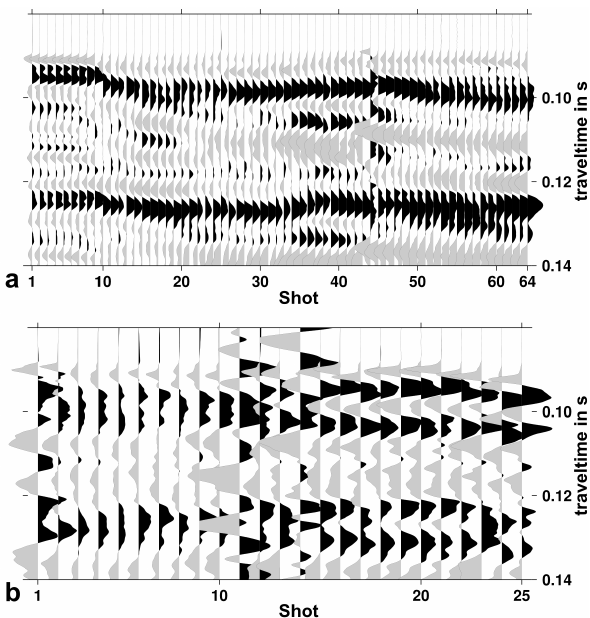
Figure 5. Traces of the vertical component of the 3C geophone on the surface, 100m away from the shot location, during the VSP sur- vey with the detonation cord (a) and booster (b) as the